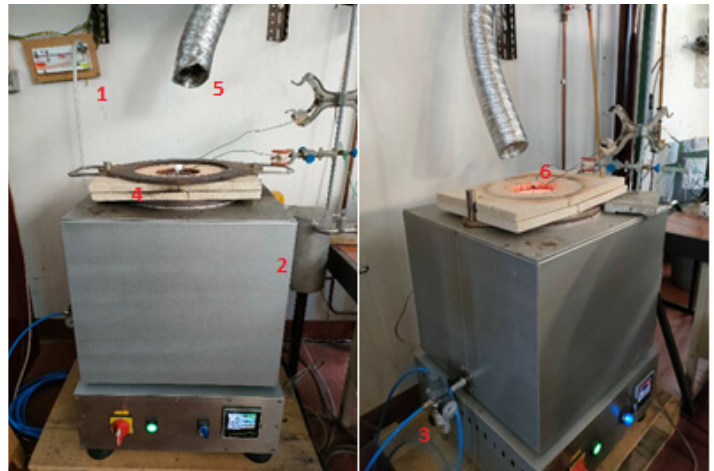
Figure 1. Developed test rig and its elements for fire resistance